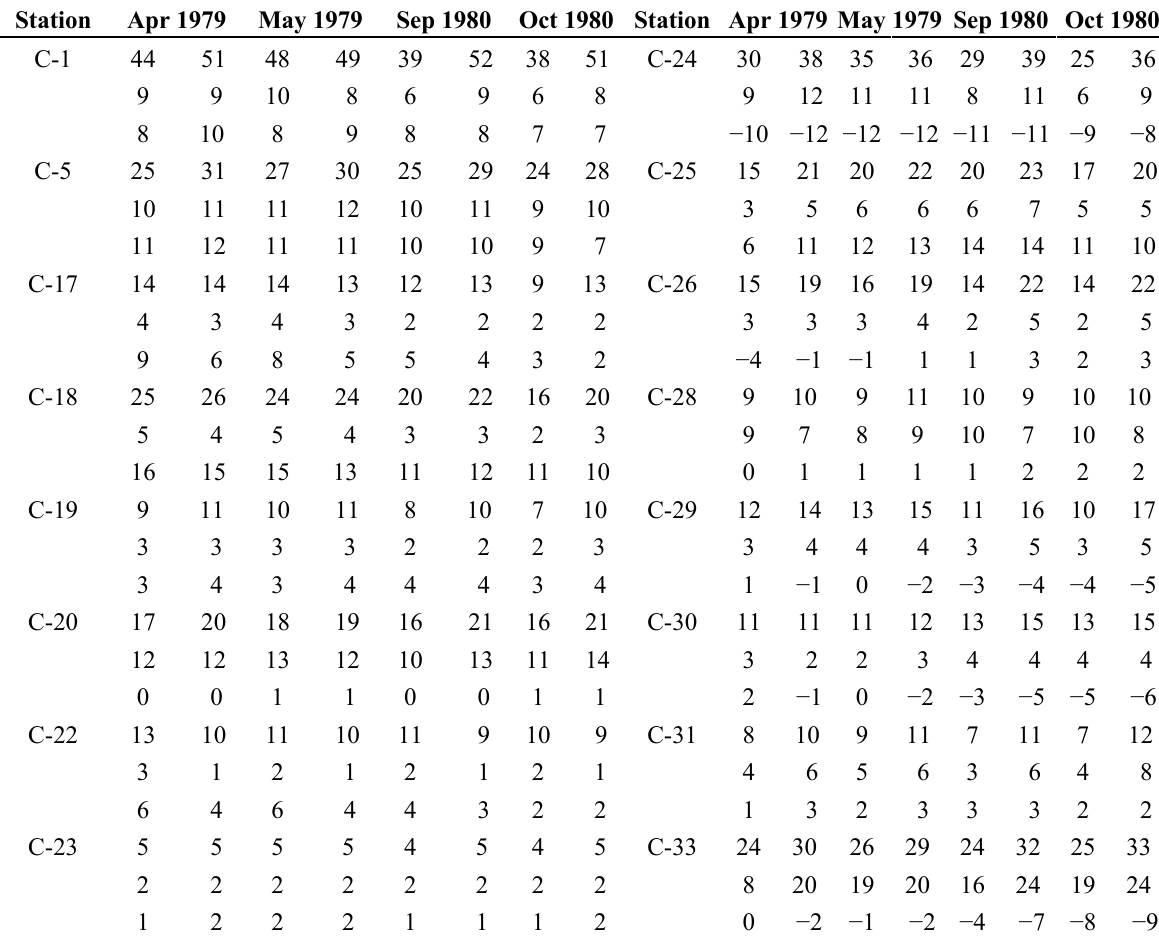
Table 4. Principal Current Direction Mid-Level Current Speed Tidal Calibration: April 1979–October 1980. For each box, the first column of values corresponds to the first 15 days of the month, with the second column of values denoting the remaining portion. Within each column: Row 1 corresponds to the RMSE in cm/s. Row 2 corresponds to the Willmott Relative Error in percent. Row 3 corresponds to the model mean in cm/s. Note the predicted mean current speed is